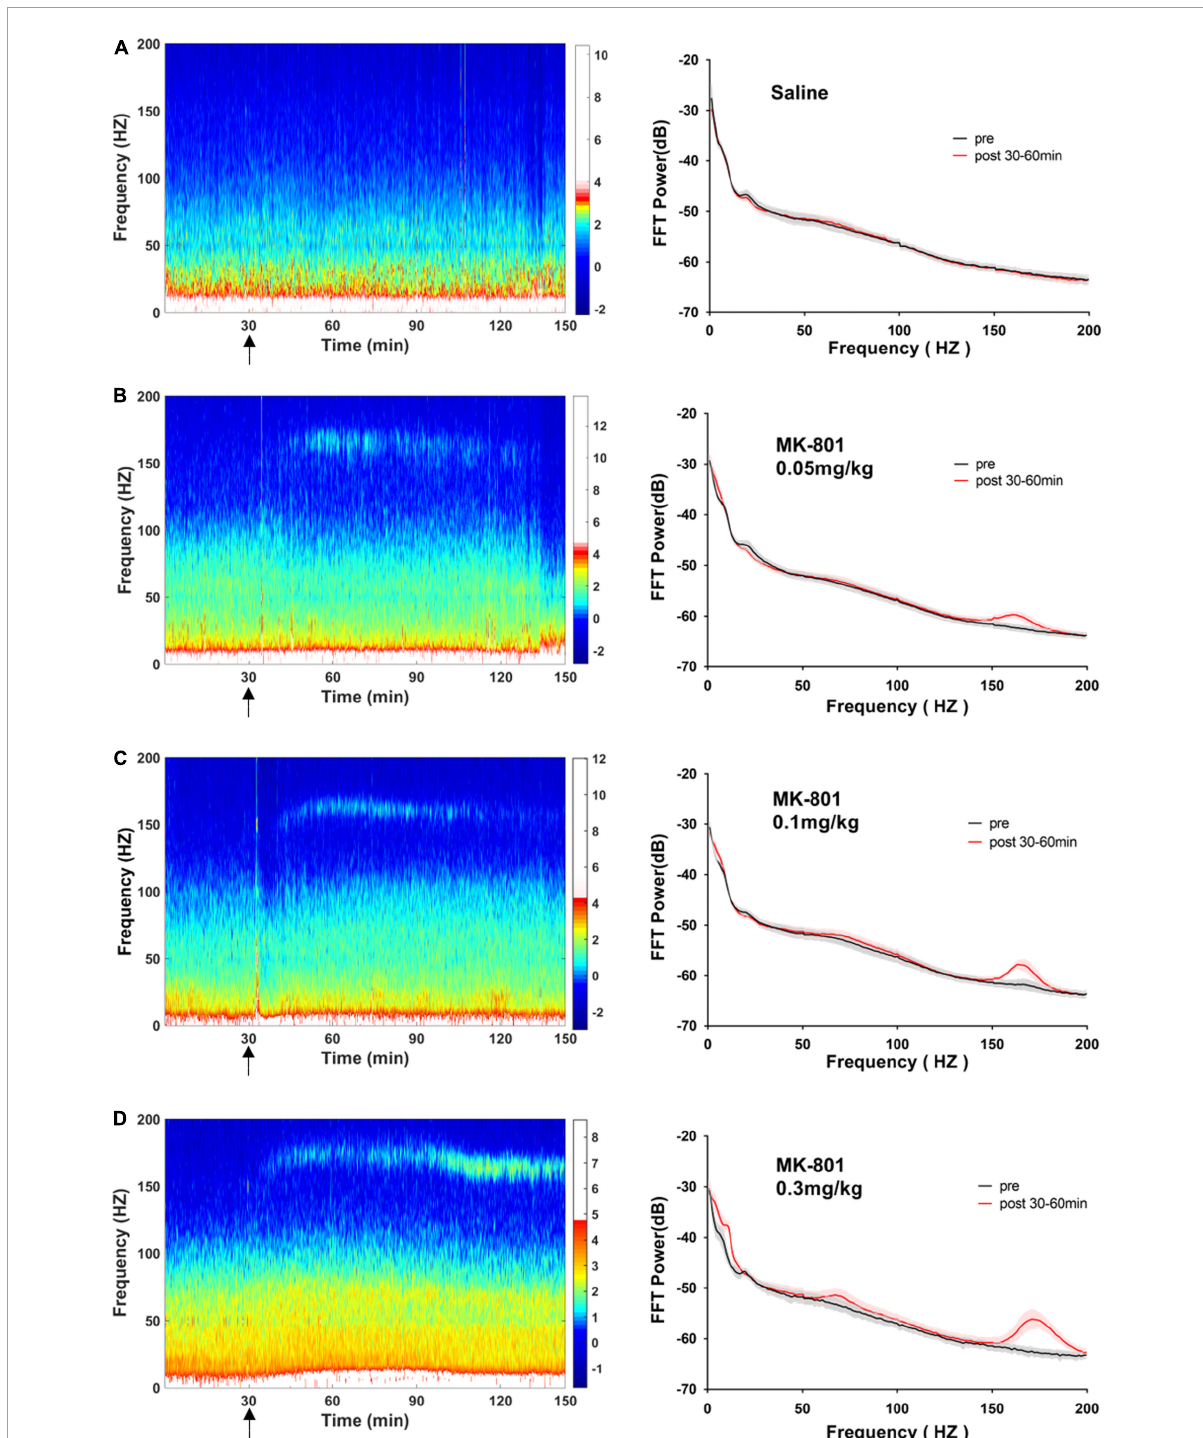
FIGURE4 Effects of MK-801 on LFP in the prefrontal cortex. The left panels showed the heatmap for time courses of changes in LFP power. The right panels showed the averaged power spectrum density (PSD) in all tested frequency bands. The averaged LFP power in the saline group (A) and the 0.05 mg/kg MK-801 (B) , 0.1 mg/kg MK-801 (C) , and 0.3 mg/kg MK-801 (D) groups were displayed in the form of heatmap and PSD, respectively. The arrow indicated the moment of drug injection. Intracranial electrical signals collected from 4 to 8 mice per group and were recorded continuously before and after drug administration (Saline: n = 8; MK-801, 0.05 mg/kg: n = 8; 0.1 mg/kg: n = 5; 0.3 mg/kg: n =